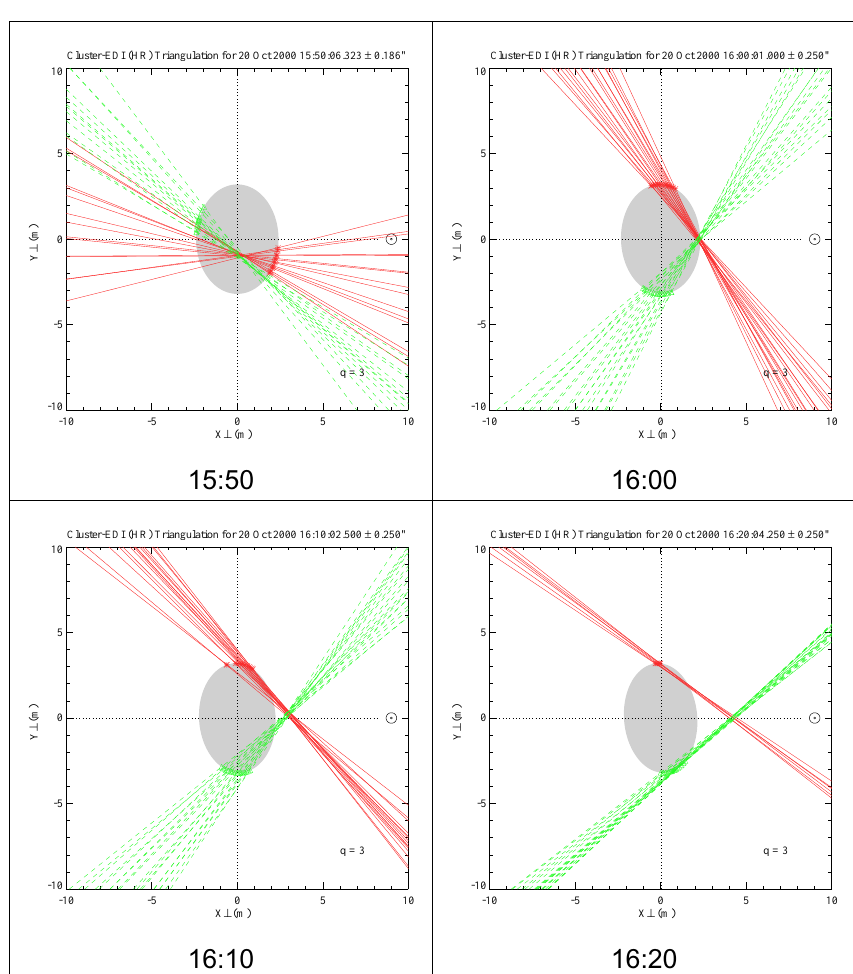
Fig. 2. Sample EDI triangulation plots for four 0.5s intervals, spaced 10min apart. Red and green lines are the firing lines of the two electron guns for those times when the beams were properly aimed to return to the detector. The gun positions (symbols) projected into the plane perpendicular to the magnetic field move on an ellipse as the spacecraft rotates through 1/8 of a spin in each panel. The measured “drift step” is the vector from the beam intersection to the center of the